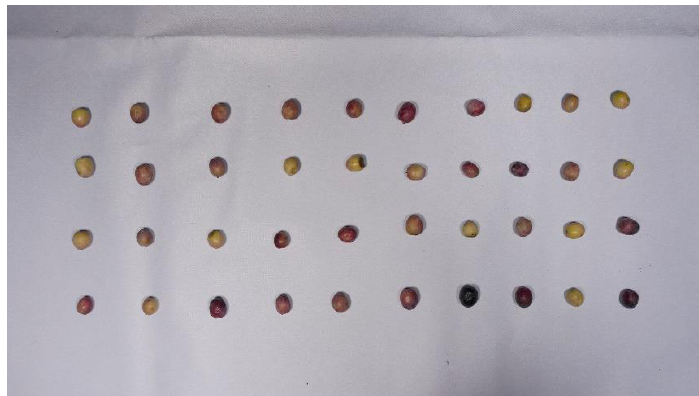
Figure 1. Example of image captured of the A1 set.